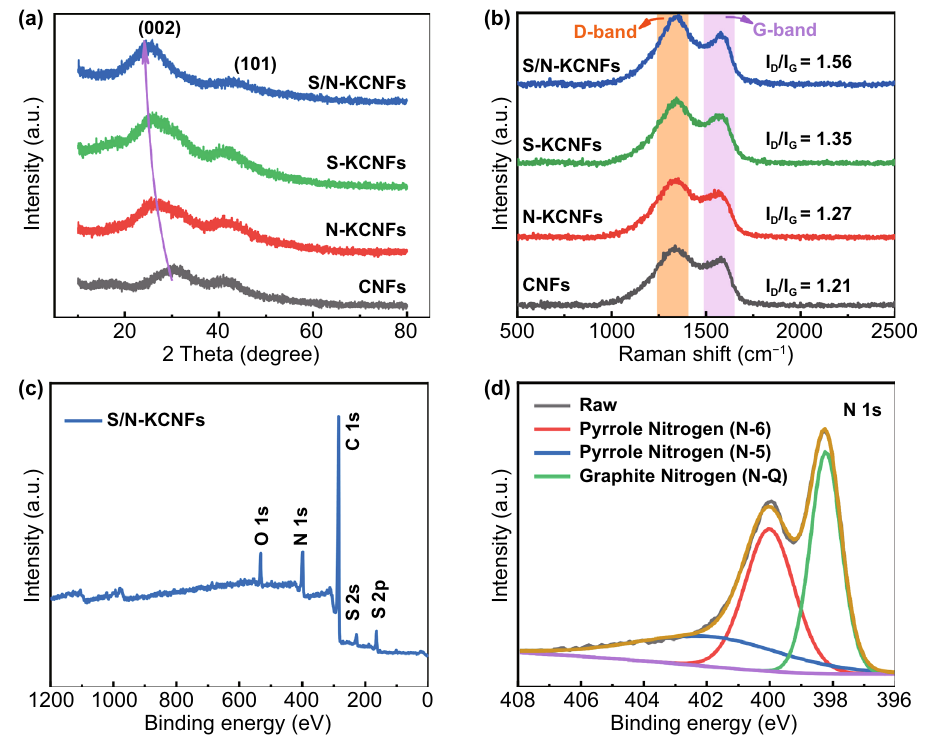
Fig. 5 a XRD spectra and b Raman spectra of S/N-KCNFs, S-KCNFs, N-KCNFs and CNFs; c XPS measurement spectra of S/N-KCNFs; d high-resolution N 1 s spectra of